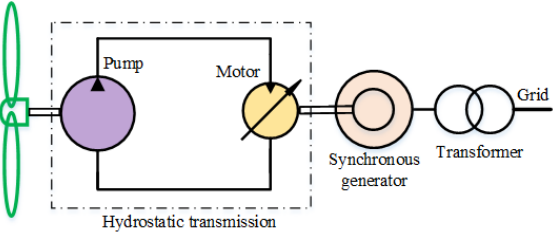
Figure 1. HST wind turbine